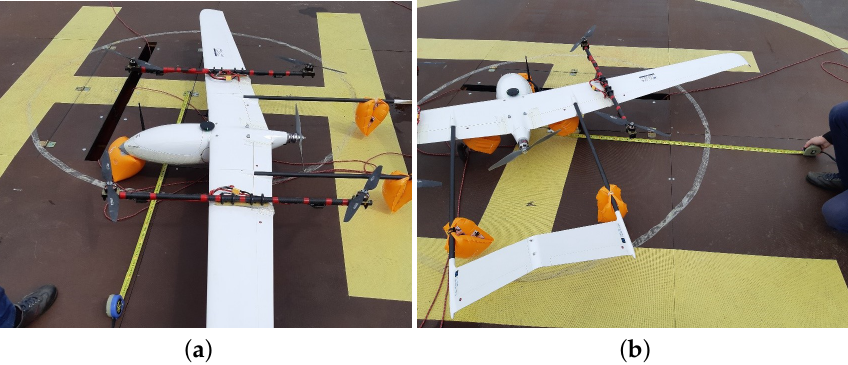
Figure 17. Albatross VTOL: ( a ) worst result—landing at a distance of 65 cm from the center of the landing pad; ( b ) best result—landing at a distance of 26 cm from the center of the landing pad.